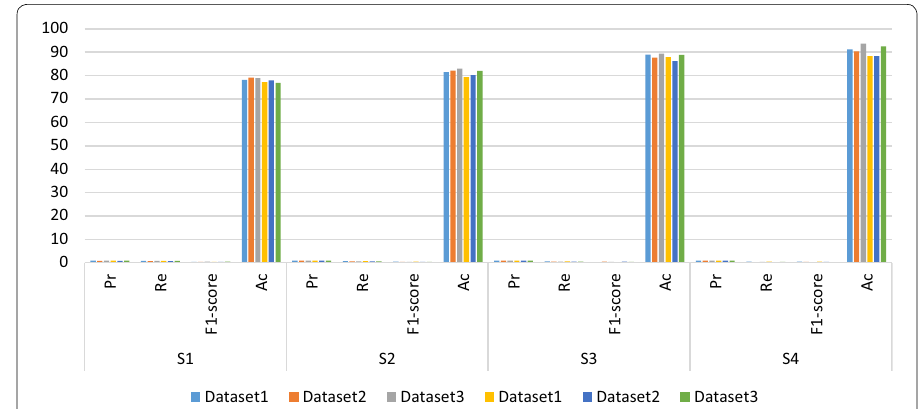
Fig. 5 Performance of existing proposed mechanism with respect to different performance metrics